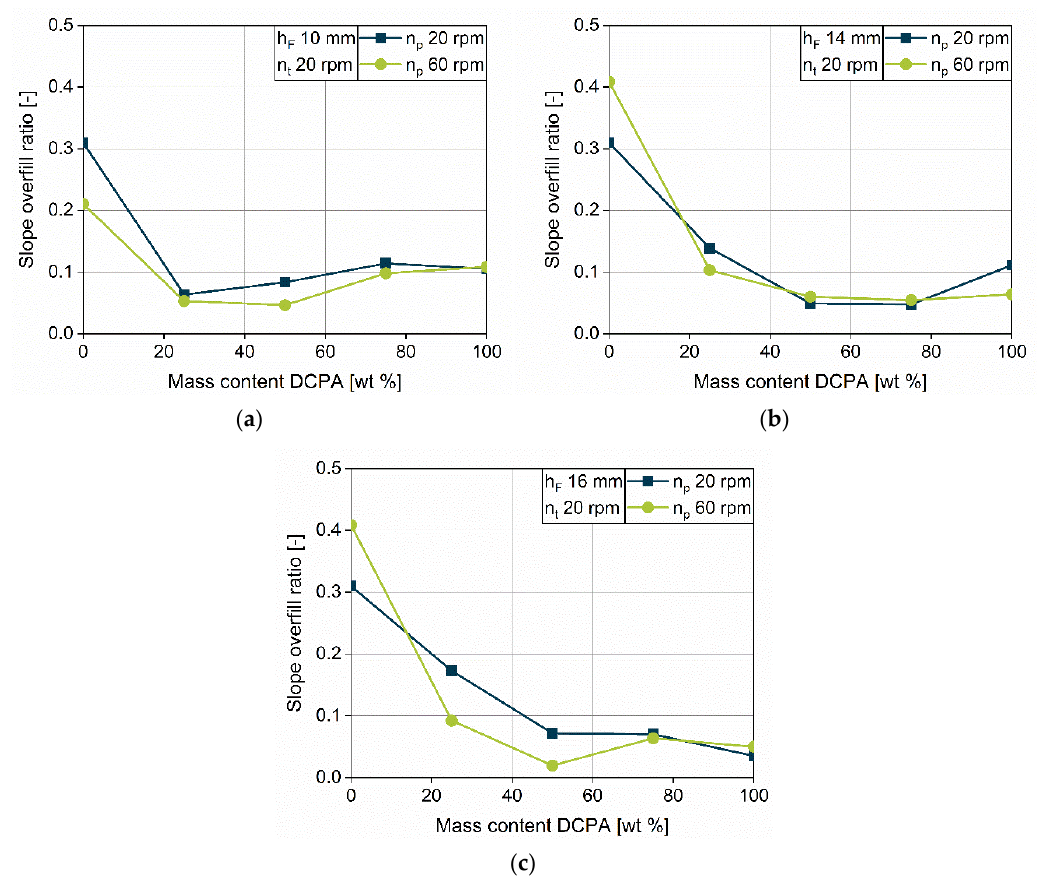
Figure 14. Slope of the linear fits of filling yield over the overfill ratio in dependence on the mass content of DCPA at a turret speed of 20 rpm at fill depth of 10 ( a ), 14 ( b ) and 16 mm ( c ). For the slope, one can observe hyperbolic courses over the mass content of DCPA at both paddle drastically with increasing DCPA content. A high positive slope indicates a strong impact of the overfill ratio on the apparent density inside the die. Unexpectedly, the slopes of the blends are almost as low as for DCPA, which does not correlate with the Compressibility index (Section 4.1). Therefore,